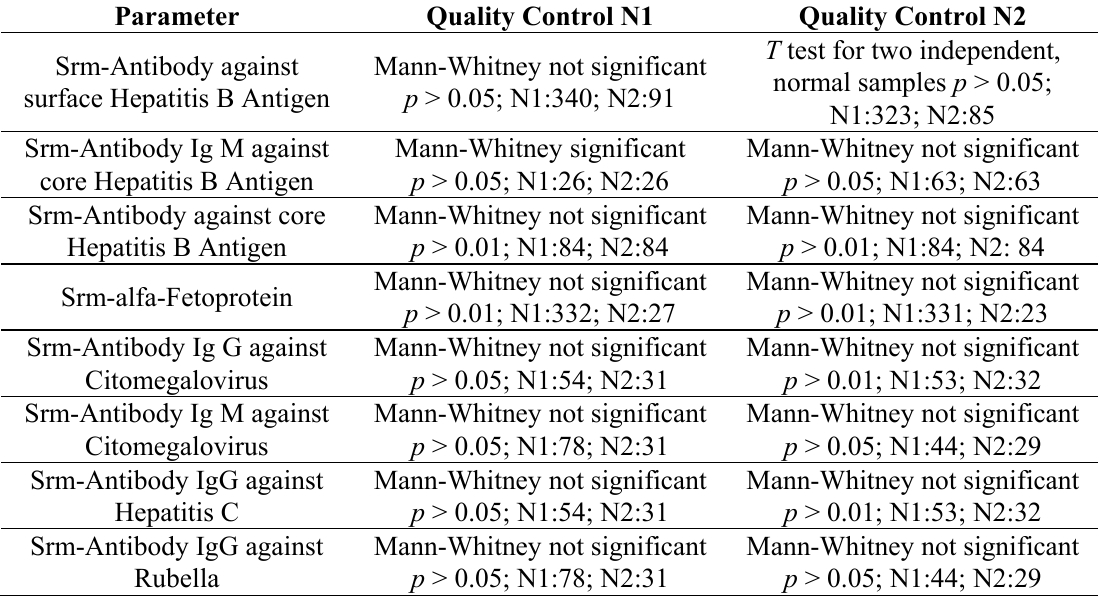
Table 4. Statistical technique applied to each level of quality control per parameter and its meaning, incorporated as a unique analytical